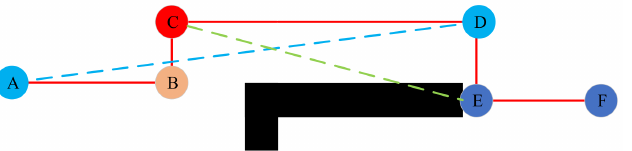
Figure 5. Elimination of redundant points. The letters A–F represent nodes in the planned path, red lines represent planned paths, blue and green lines represent lines between nodes, and black represents